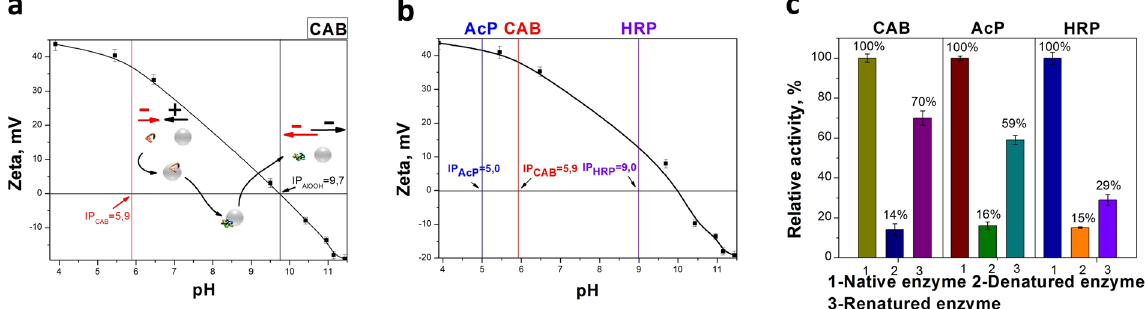
Figure 4. ( a ) The pH-dependence of the electrostatic interactions of CAB with the alumina NPs. ( b ) The zeta potentials of the alumina NPs and the isoelectric points of the three enzymes. ( c ) The renaturation yields of CAB, AcP and HRP after separation from the alumina NPs.